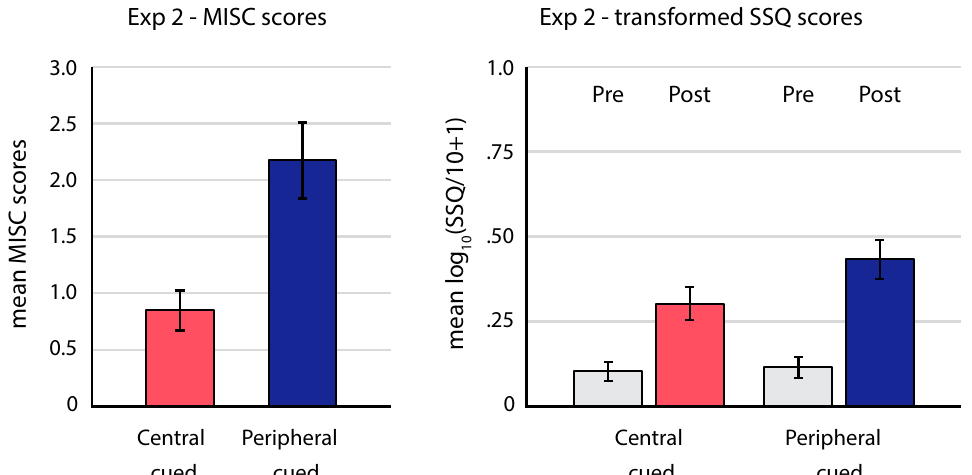
Fig. 9 Motion sickness in the central-cued (red) vs peripheral-cued (blue) conditions of Experiment 2. The left graph plots mean MISC scores. The right graph plots mean SSQ scores after transforming by log 10 (SSQ/10 errors of the